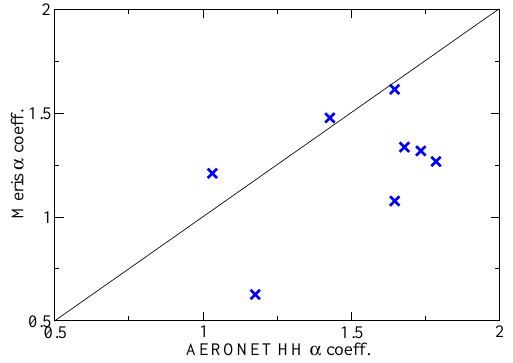
Fig. 10. Comparisons of M ERIS /P MBAER and national air quality Fig. A10. Comparisons of M ERIS /P MBAER and national air qual- measurements PM 10 in Hamburg. The annotation denotes the gaug- ity measurements PM 10 in Hamburg. The annotation denotes the ing station and the site location ( BG = background, IND = industry, gauging station and the site location ( BG = background, IND = in- TRAF = dustry, TRAF = traffic).